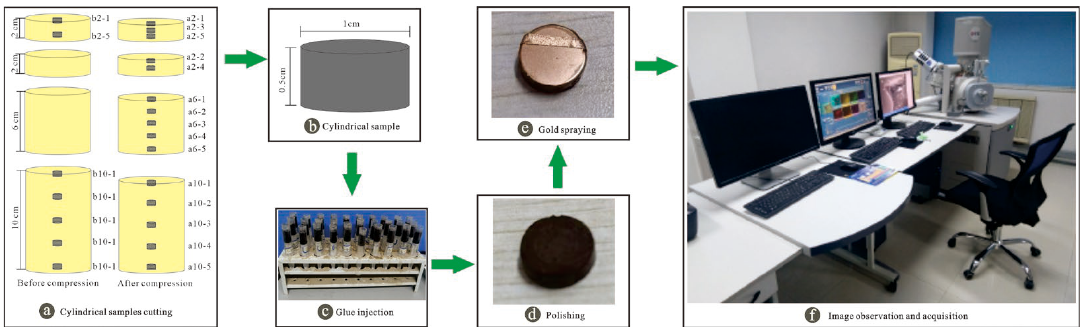
Figure 4. Preparation of cylindrical specimens for SEM tests.